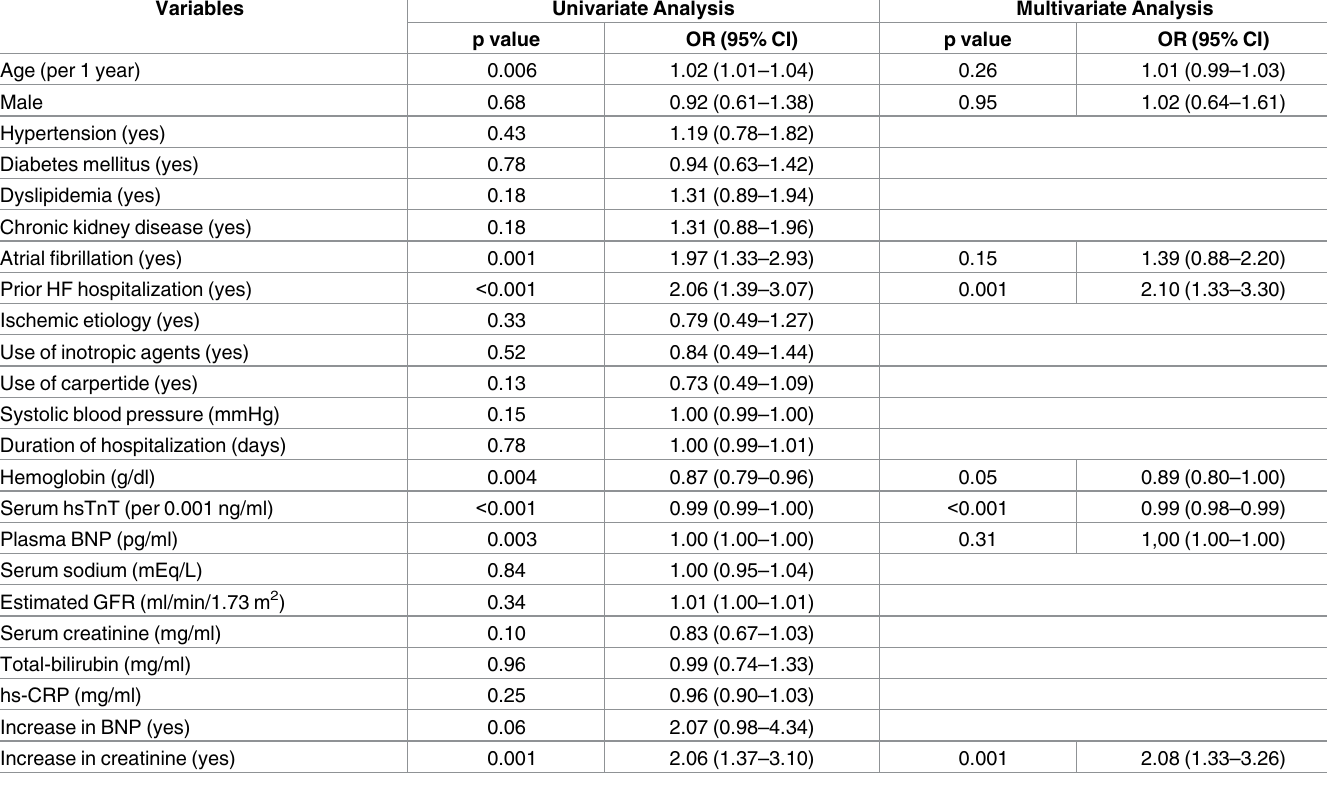
Table 3. Results of univariate and multivariate logistic regression analysesfor stable or rising hsTnT levels at discharge.